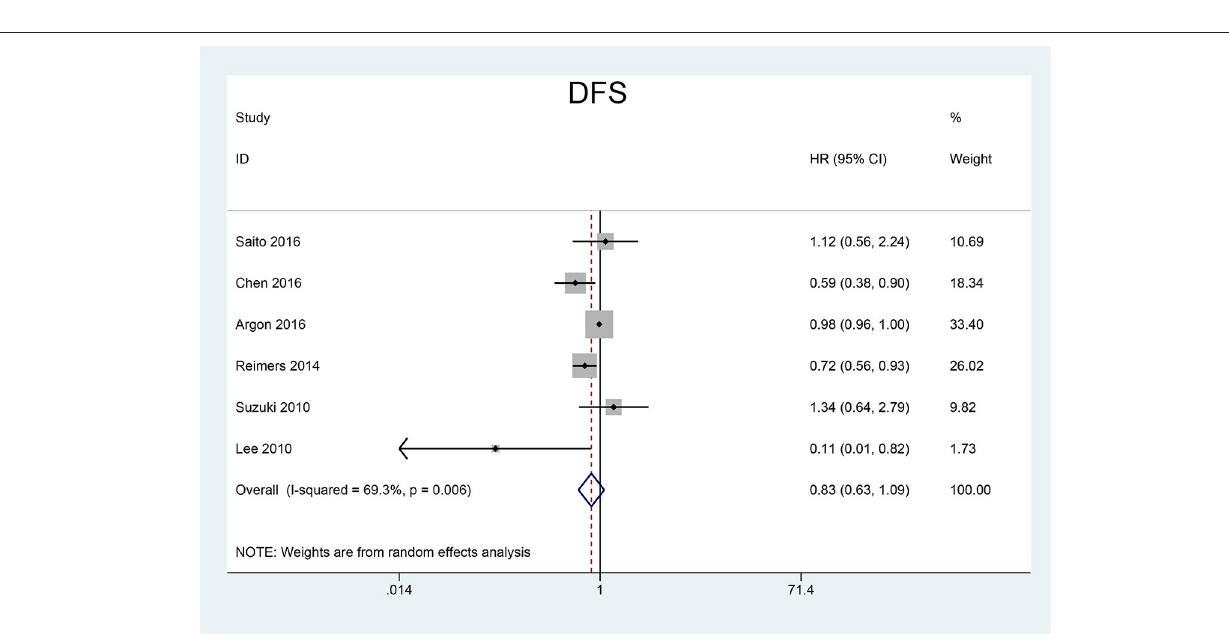
P = 0.951), gender (OR = 0.95, 95% CI = 0.80–1.12, P = 0.533), tumor stage (OR = 0.96, 95% CI = 0.29–3.22, P = 0.947) and lymph node metastasis (LNM) (OR = 0.90, 95% CI = 0.51–1.57, P =